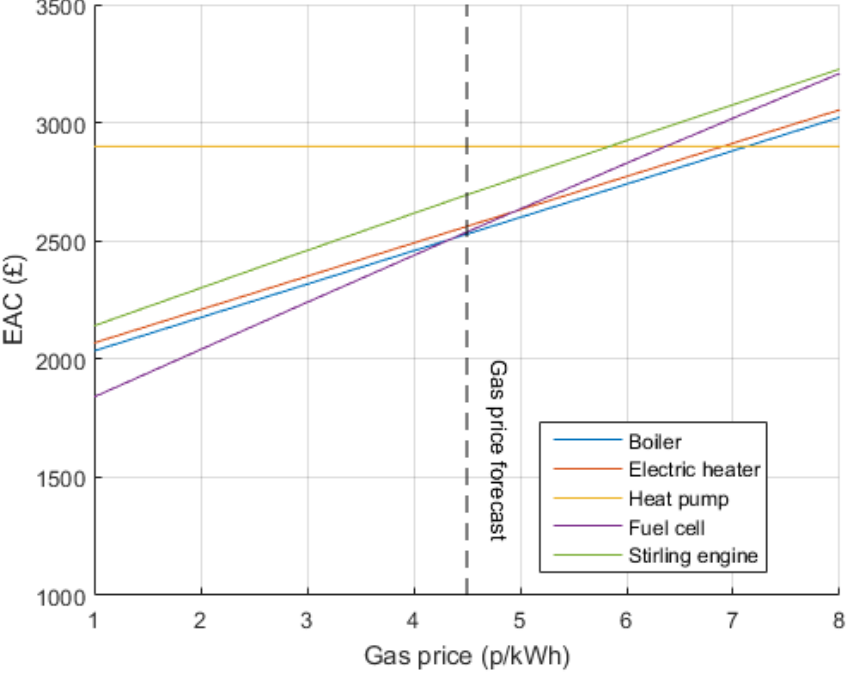
Figure 11. Equivalent Annual Cost sensitivity to natural gas price in the long run electricity price regime.